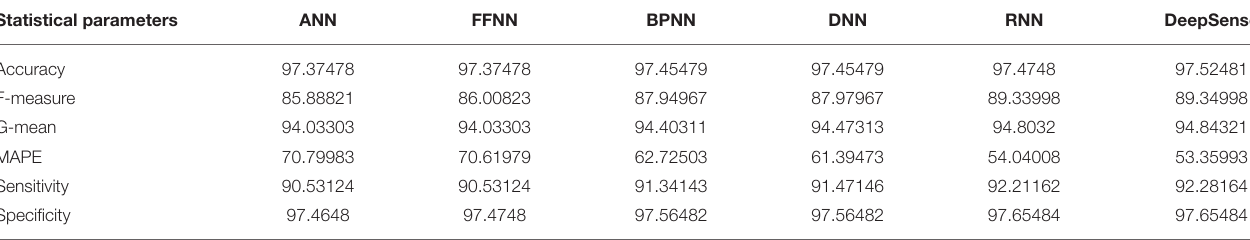
TABLE 8 | Results of statistical parameters for COVID-CT with 90% training data on 1,000 images classifier. Statistical parameters